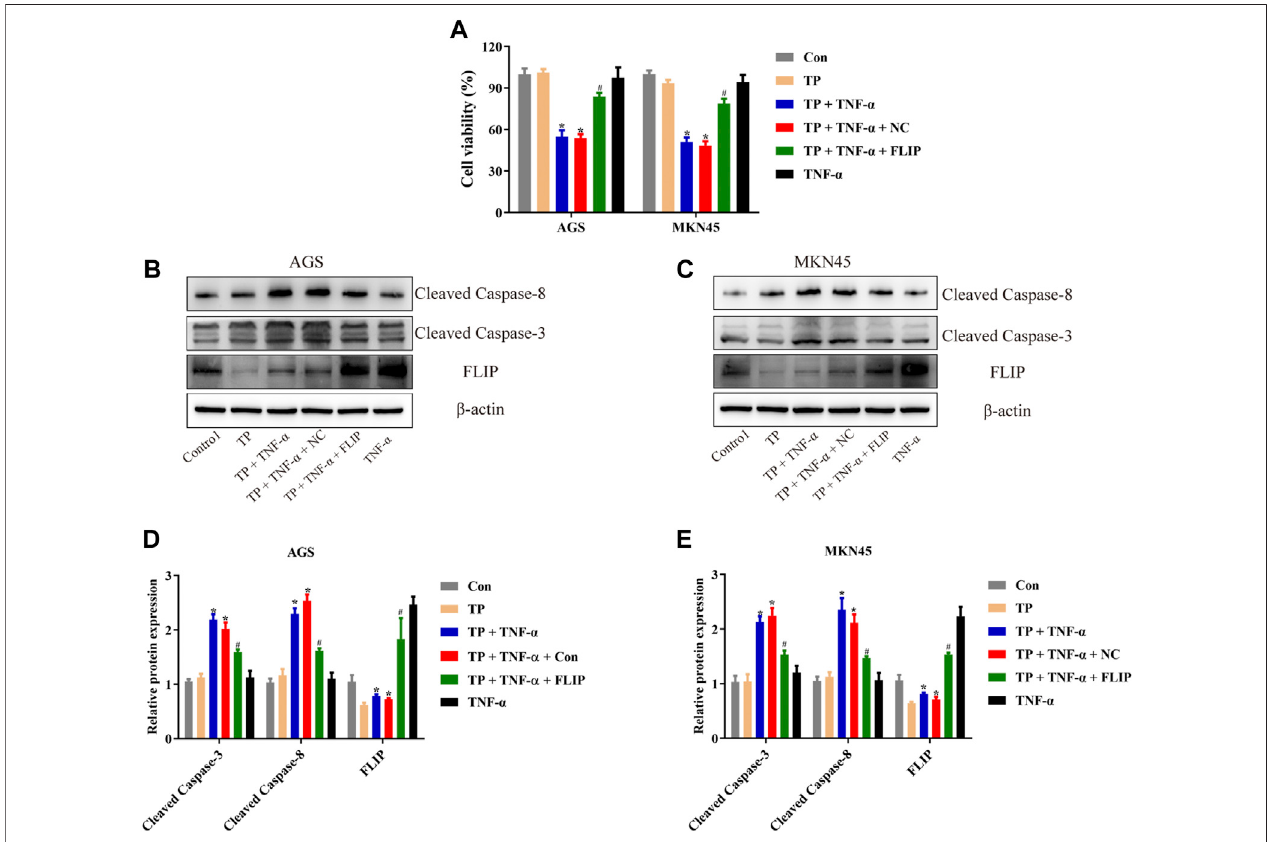
FIGURE3| OverexpressionofFLIPprotectedAGSandMKN45cellsfromTP/TNF- α – inducedapoptosis. (A) CellviabilityofAGSandMKN45cellstransfectedwith a plasmid carrying FLIP sequence or its negative control with subsequent treatment with TP (25 nM) and TNF- α (5 ng/ml) for 24 h. (B – E) Representative western blots and relative intensity of protein bands of cleaved caspase-3, cleaved caspase-8, and FLIP in AGS and MKN45 cells transfected with FLIP plasmid and treated with TP (25 nM) and TNF- α (5ng/ml),24hafter TNF- α application, with β -actin astheloadingcontrol. Results wereexpressed asmean± SEM,and statistical analysiswas performedusingtwo-wayANOVAfollowedbyTukey ’ smultiplecomparisontest.* ,# p < 0.05( n ≥ 3).* p compared withthecontrolgroupand # p compared withTP/TNF- α /NC-treated